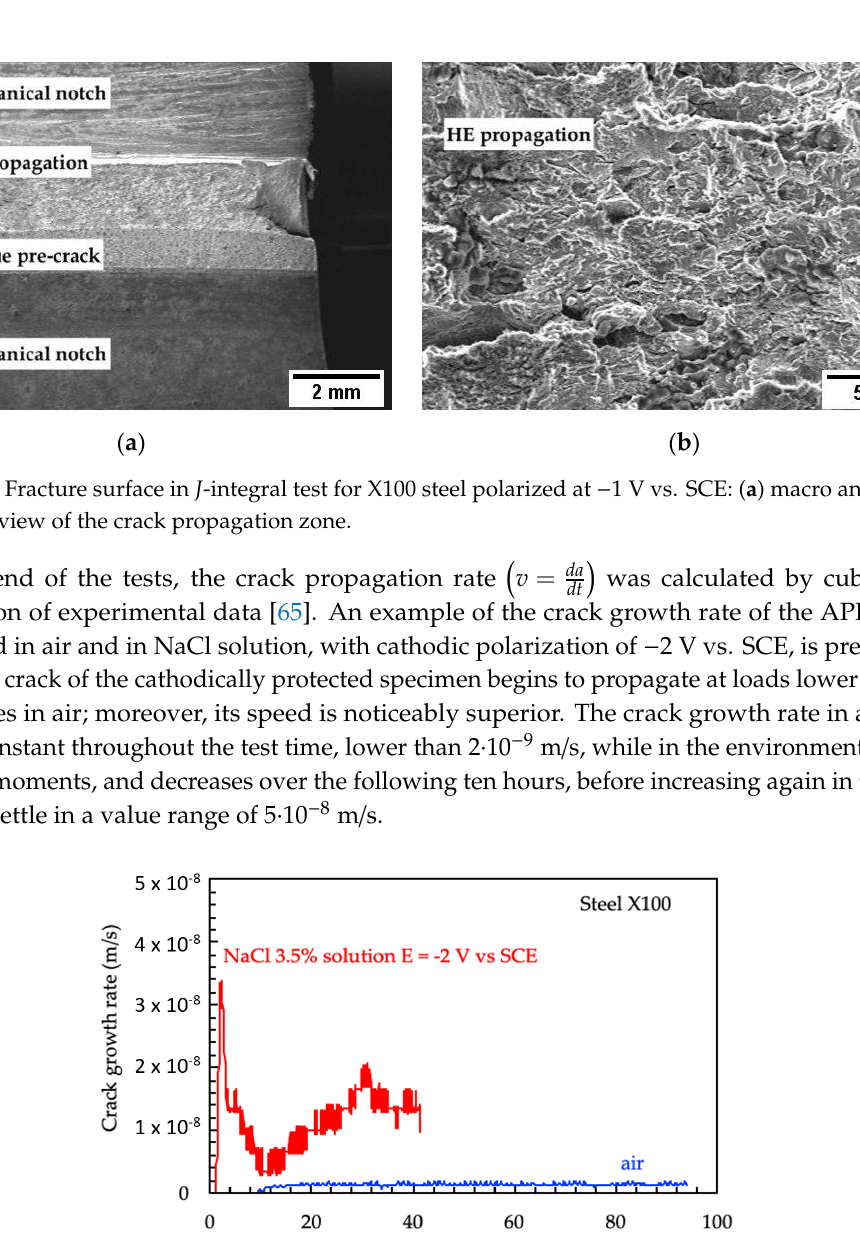
Figure 7. Fracture surface in J-integral test for X80 steel polarized at −1 V vs. SCE: ( a ) macro and ( b ) close-up view of the fatigue pre-cracking crack propagation transition zone.